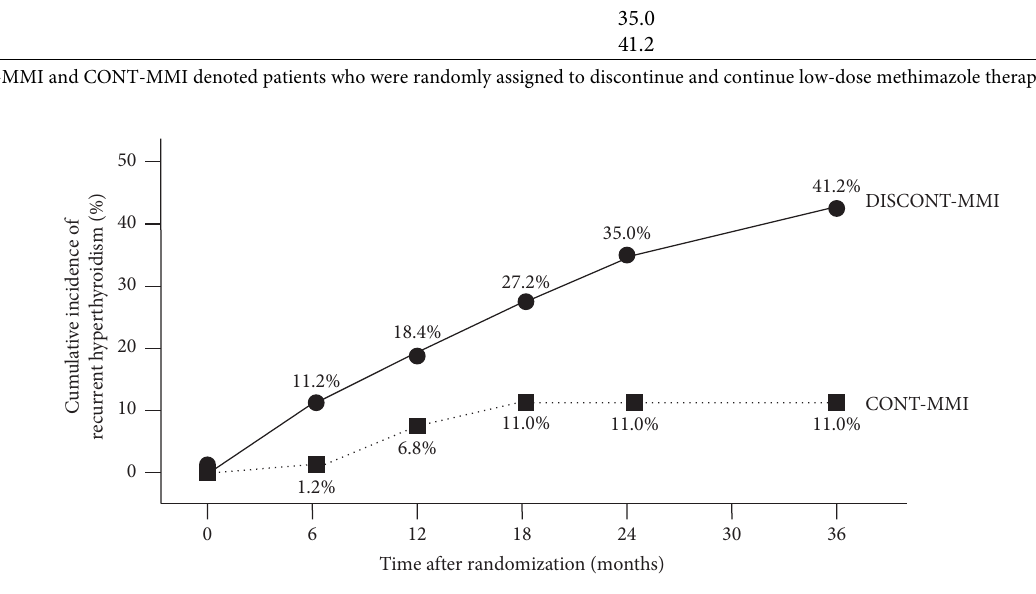
Figure 2: Cumulative rates of recurrent hyperthyroidism in Graves’ hyperthyroid patients who were randomly assigned to continue (CONT-MMI) (83 cases) represented in a dotted line and to discontinue low-dose methimazole therapy (DISCONT-MMI) (90 cases) represented in a solid